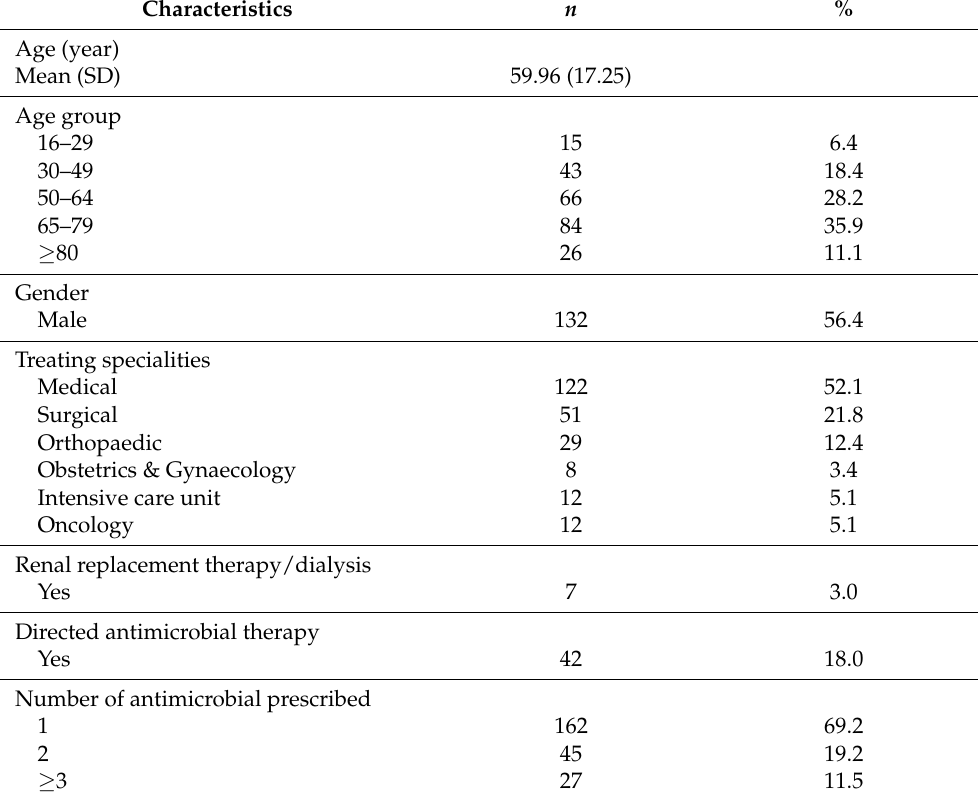
Table 1. Characteristics of patients receiving antimicrobial prescriptions ( n =